Question: What style of plot is this figure drawn as?
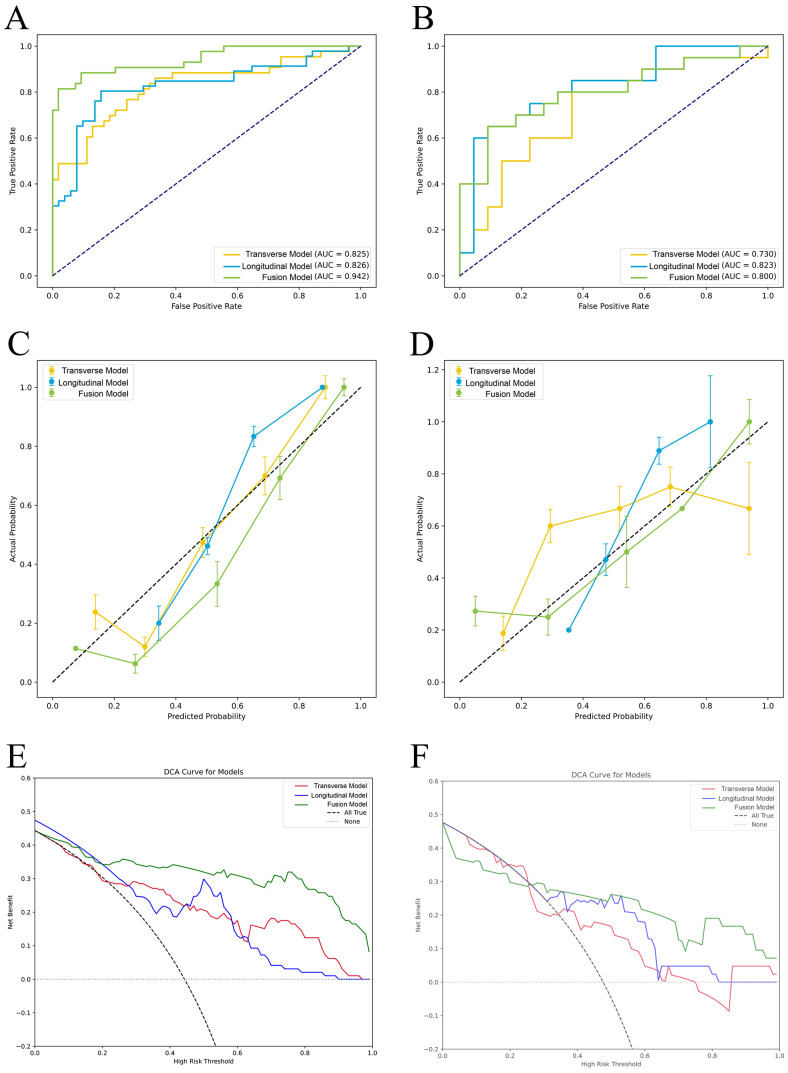
Answer: line